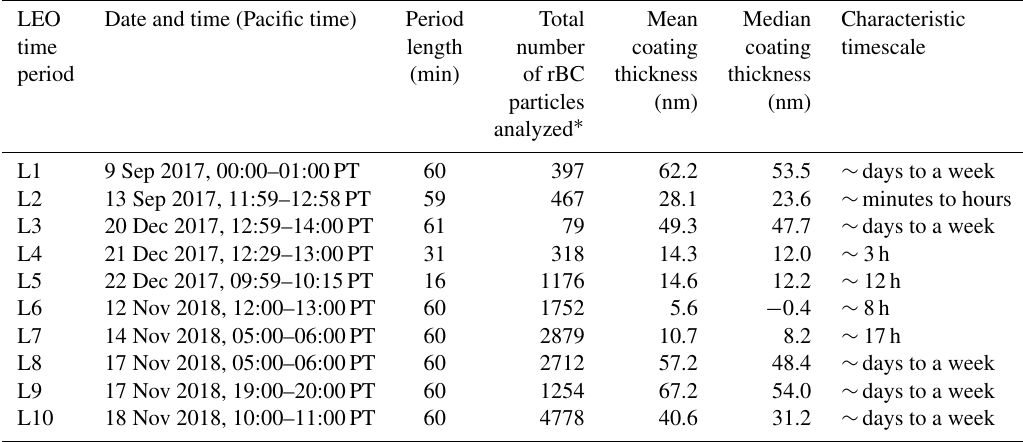
Table 2. Details of the 10 different LEO time periods. Further details about the source-to-receptor characteristic timescales can be found in Sect. S1. LEO Date and time (Pacific time) Period Total Mean Median Characteristic time length number coating coating timescale period (min) of rBC thickness thickness particles (nm) (nm) analyzed